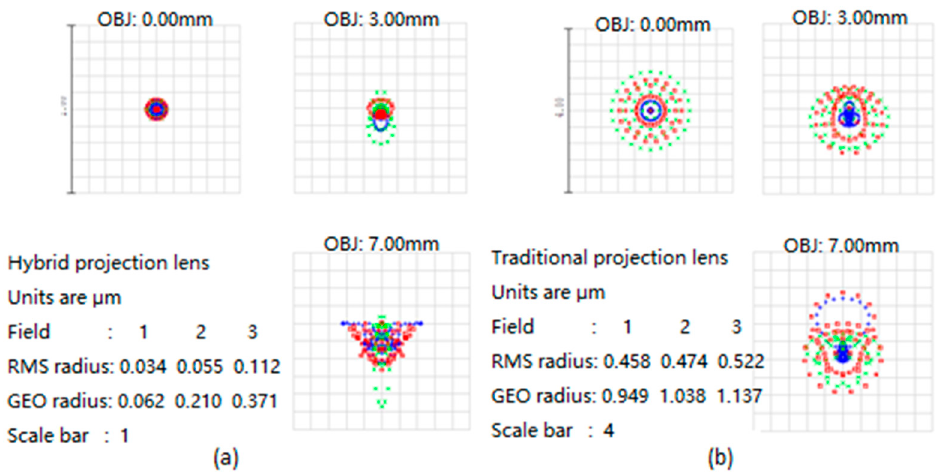
Figure 8. Spot diagram of different fields of view for hybrid ( a ) and traditional ( b ) projection lens systems.